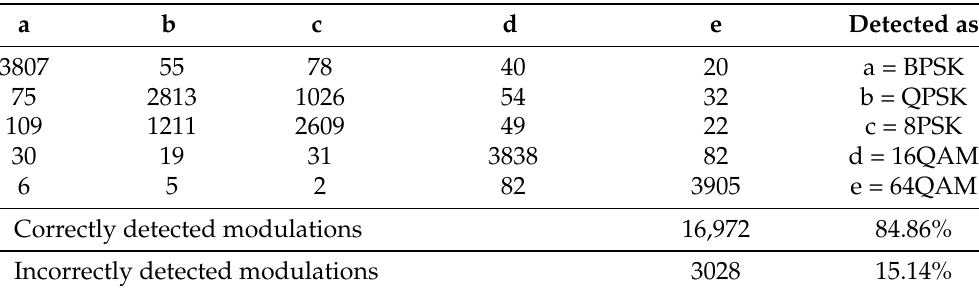
Table 5. Confusion matrix for random committee using random tree as a base MLT with L = 3,